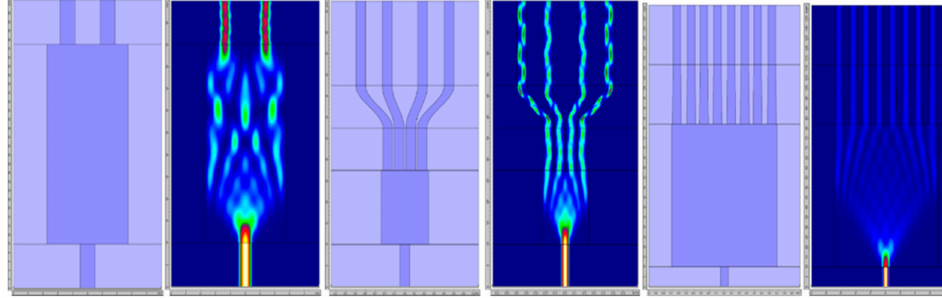
Figure 3. Schematics of simulated 1 × 2, 1 × 4, and 1 × 8 MMI optimized for 660 nm with matched color-maps of total EM-field intensity averaged over Z -axis of structures. X- and Y -axis scales are not matched for better